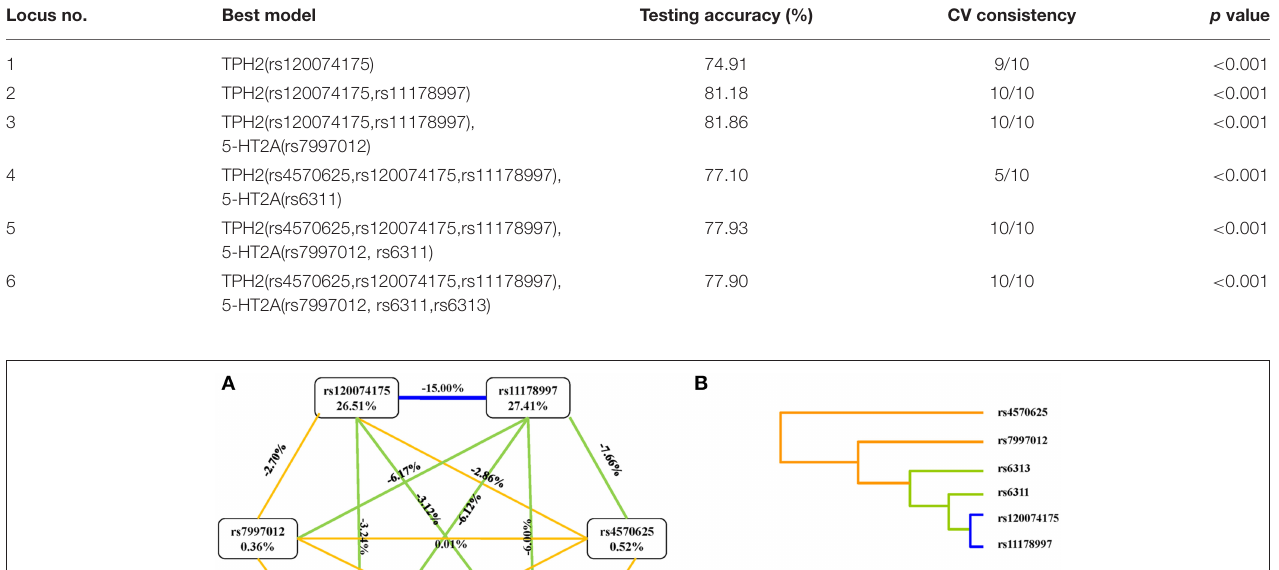
TABLE 5 | The best gene-gene interaction models obtained by GMDR. Locus no.